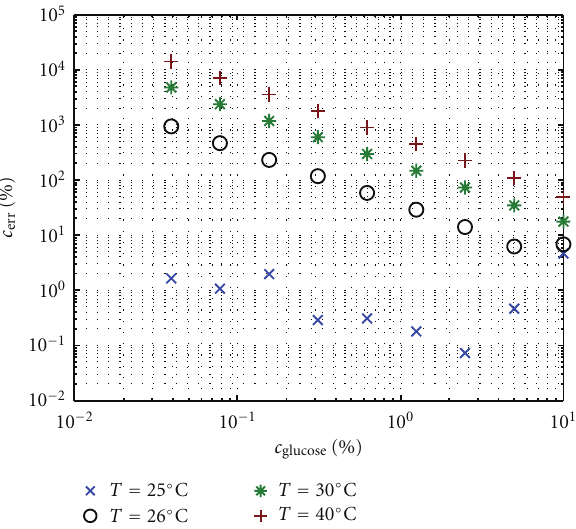
Figure 11: Statistical evaluation using k-fold cross-validation for nominal temperature T = 25 ◦ C and nominal wavelength ( Δ λ = 0nm). The grey line denotes the 2% error level.